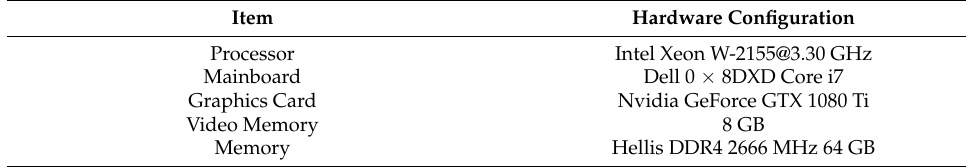
Table 2. Hardware platform configuration.